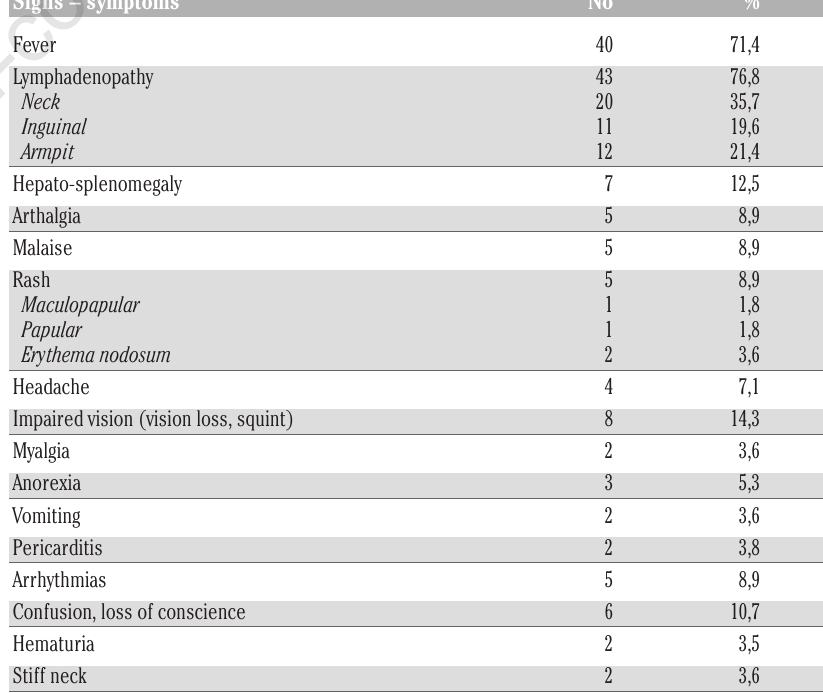
Table 2. Signs and symptoms recorded among the 56 confirmed Cat-scratch disease